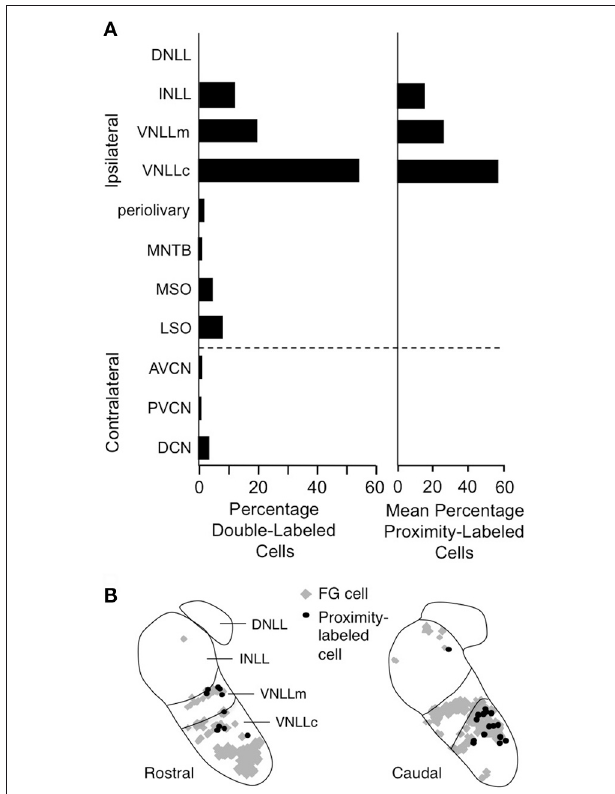
FIGURE 13 | Lateral lemniscal nuclei provide key glycinergic inputs to facilitated combination-sensitive neurons in IC. (A) Left . Average percentages of neurons double-labeled by tracer (FluoroGold, FG) deposited at IC combination-sensitive recording sites and by glycine immunohistochemistry. This represents the distribution of glycinergic inputs to IC regions containing facilitated combination-sensitive neurons. Right . Distribution of “proximity-labeled neurons”; these neurons are retrogradely labeled by the IC tracer deposits and within 50 µ m of a labeled terminal resulting from deposit of a second tracer in a low frequency part of AVCN. This represents neurons that likely receive input tuned to 23–30kHz and project to high-ChF, combination-sensitive recording sites in IC. (B) Locations of these “proximity labeled” cells in VNLL and INLL from one experiment. Adapted from Yavuzoglu et al. (2011), with